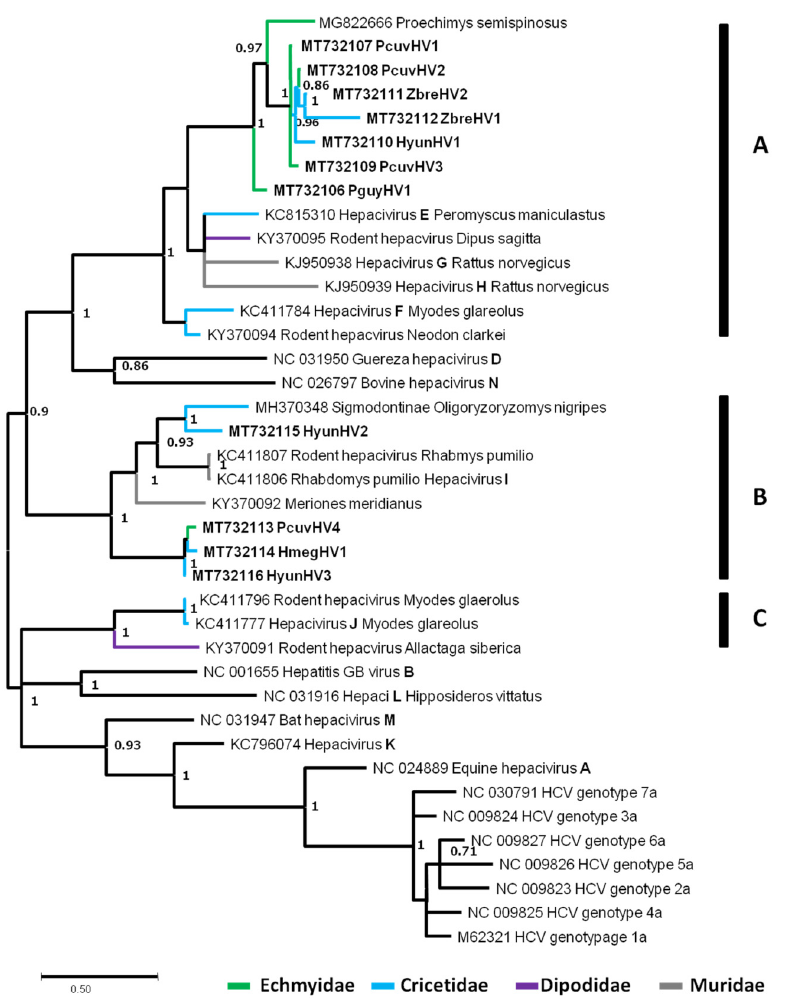
Figure 6. Unrooted phylogenetic tree based on the ns5b (alignment of 135 amino acid positions) of rodent hepaciviruses (RHVs). The tree was inferred from amino acid sequences using the Bayesian method with the WAG model. Sequence identifiers include the NCBI accession number and the isolate name. Posterior probabilities of the Bayesian analysis (>70%) are shown next to nodes. The scale bar indicates amino acid substitutions per site. The sequences identified in this study are shown in bold. The sequences identified in this study clustered in three well supported groups named A , B and C for ease of